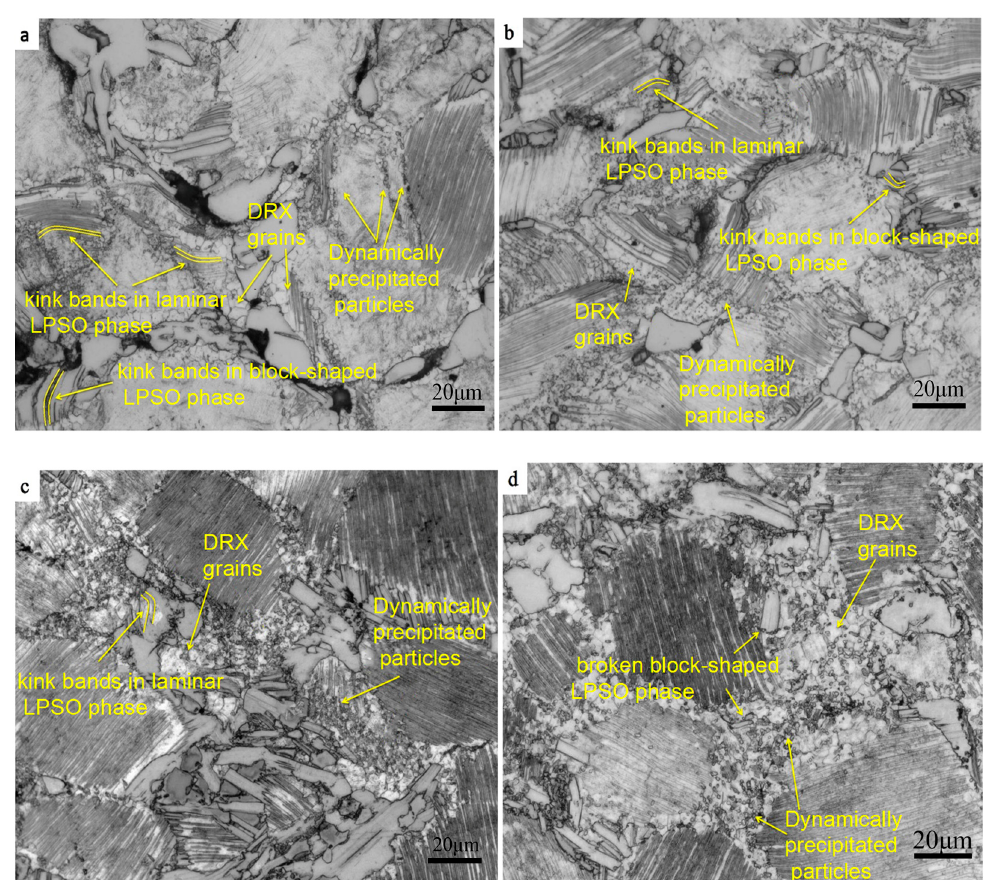
Figure 3. Microstructure of the edge region under different strain rates. ( a ) 0.5 s − 1 ; ( b ) 0.1 s − 1 ; ( c ) 0.01 s − 1 ; and ( d ) 0.001 s − 1 .